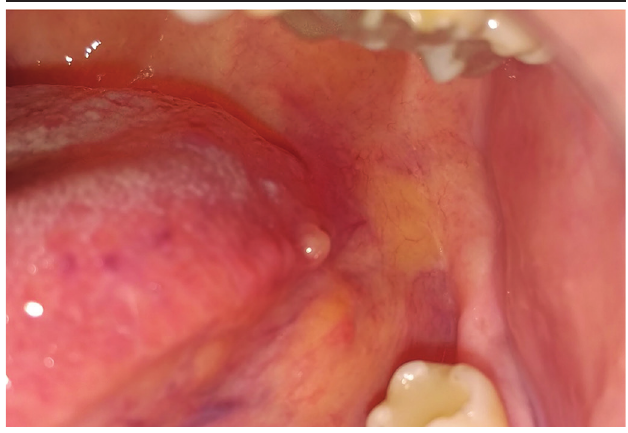
fIgure 1 – Intraoral clinical aspect: yellowish nodular lesion, measuring 0.5 cm on the right posterior lateral border of the tongue